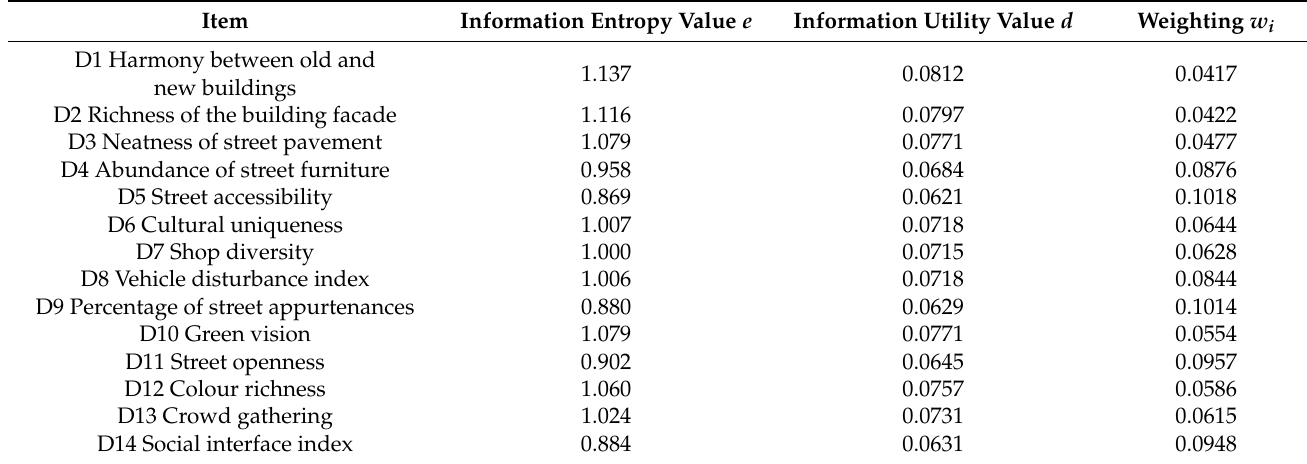
Table 6. Entropy method indicator description weighting values.